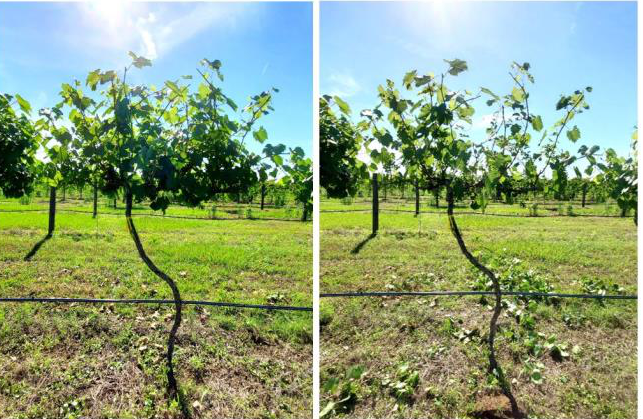
Figure 3. ‘MidSouth’ grapevine before ( left ) and after ( right ) shoot thinning to 15 primary shoots per meter in McNeill, MS (May 2021).